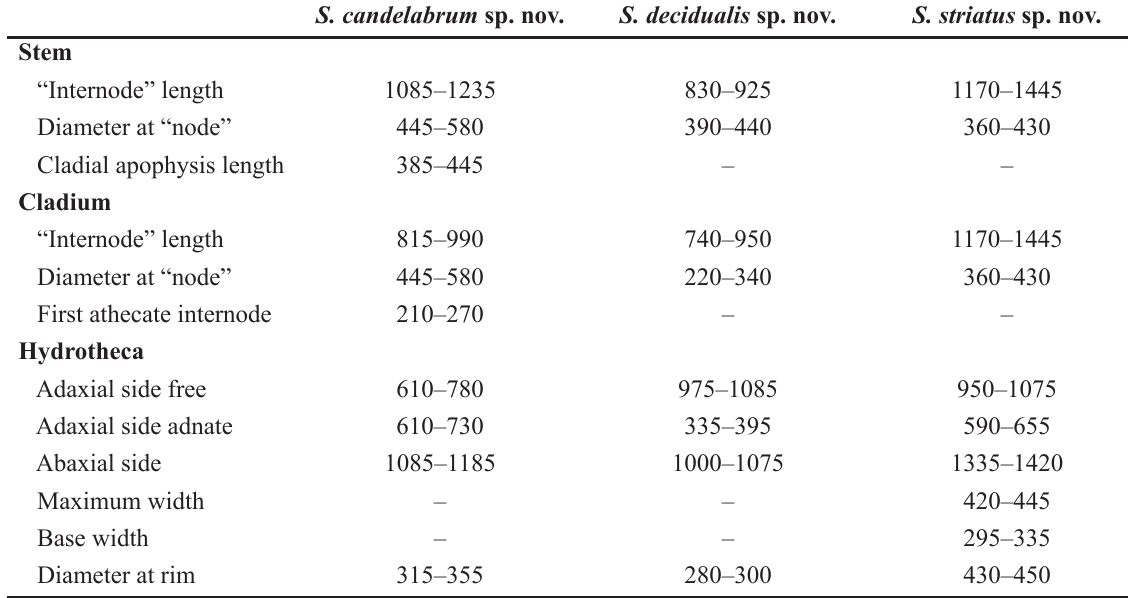
Table 2. Measurements of species of Solenoscyphus gen. nov., in